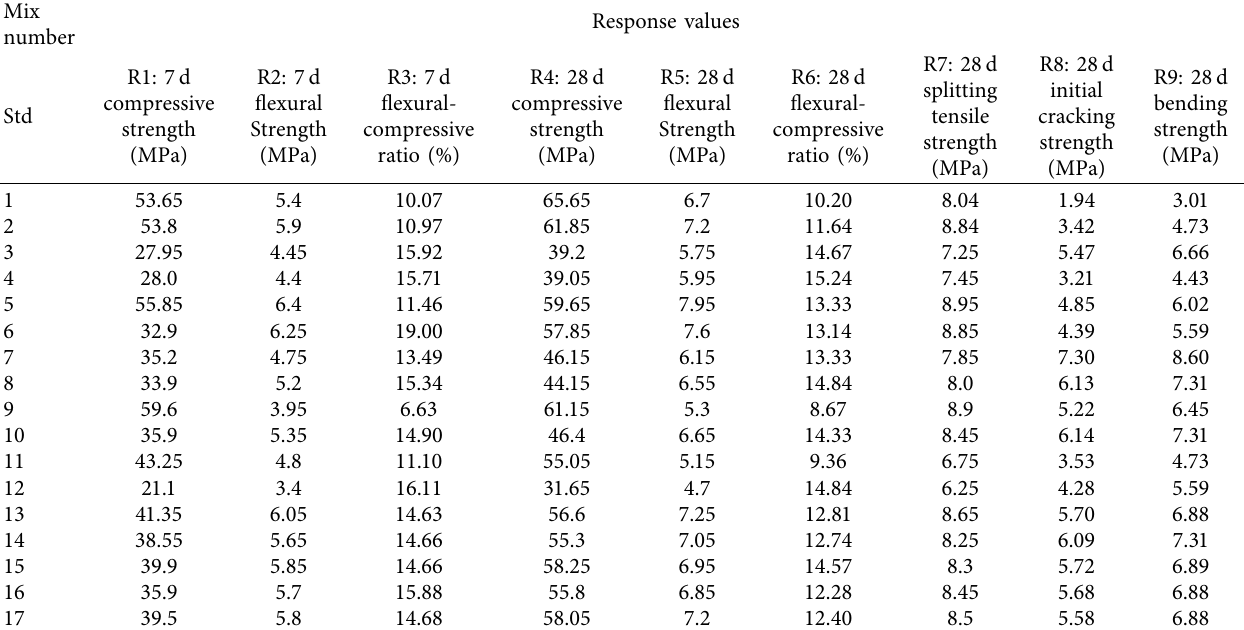
Table 6: The response results of the 17 experimental groups.